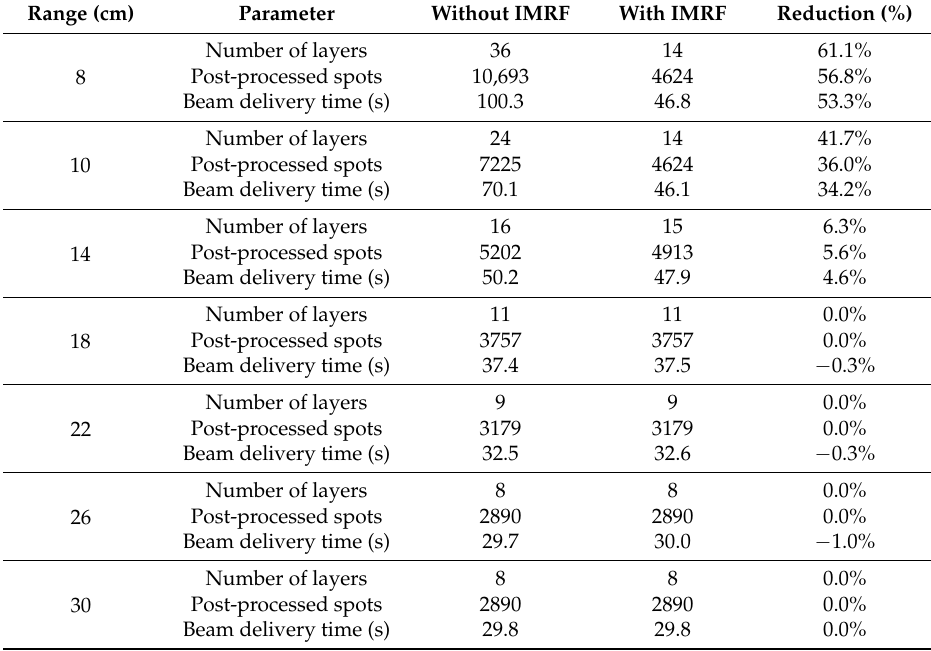
Table 1. Beam line information and beam delivery time for the phantom. The spread-out Bragg peak width is 4 cm for all ranges.